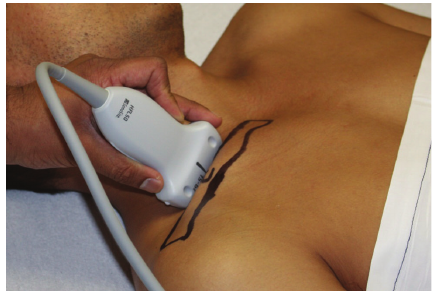
Figure 16: Ultrasound probe position for the supraclavicular brachial plexus block.